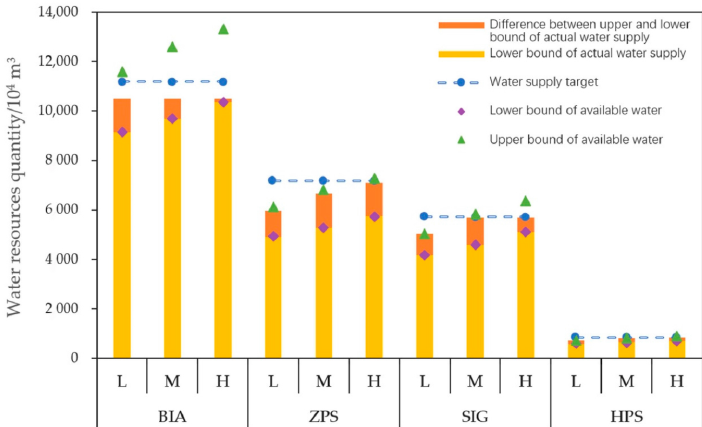
Figure 3. Comparison of the actual optimal water supply and the available water of the four water intakes under di ff erent flood flow scenarios. Note: BIA = third branch channel of the Baishatan irrigation region; ZPS = Zhushan pumping station; SIG = Shijiangfang intake gate; and HPS = Haernao pumping station. L, M, and H denote low, middle, and high flood flow scenarios,